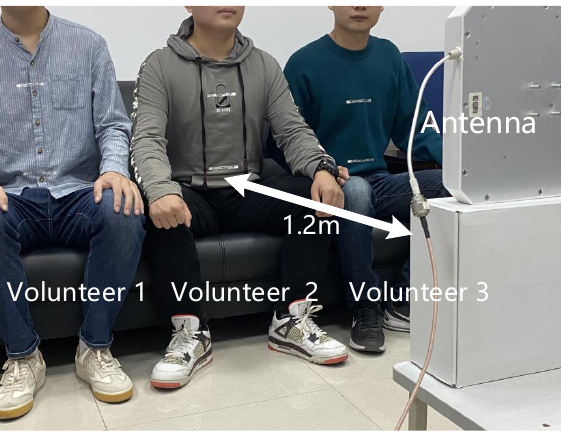
Figure 17. Multi-person respiratory monitoring experiment scenario. Table 3. Multi-person respiratory monitoring